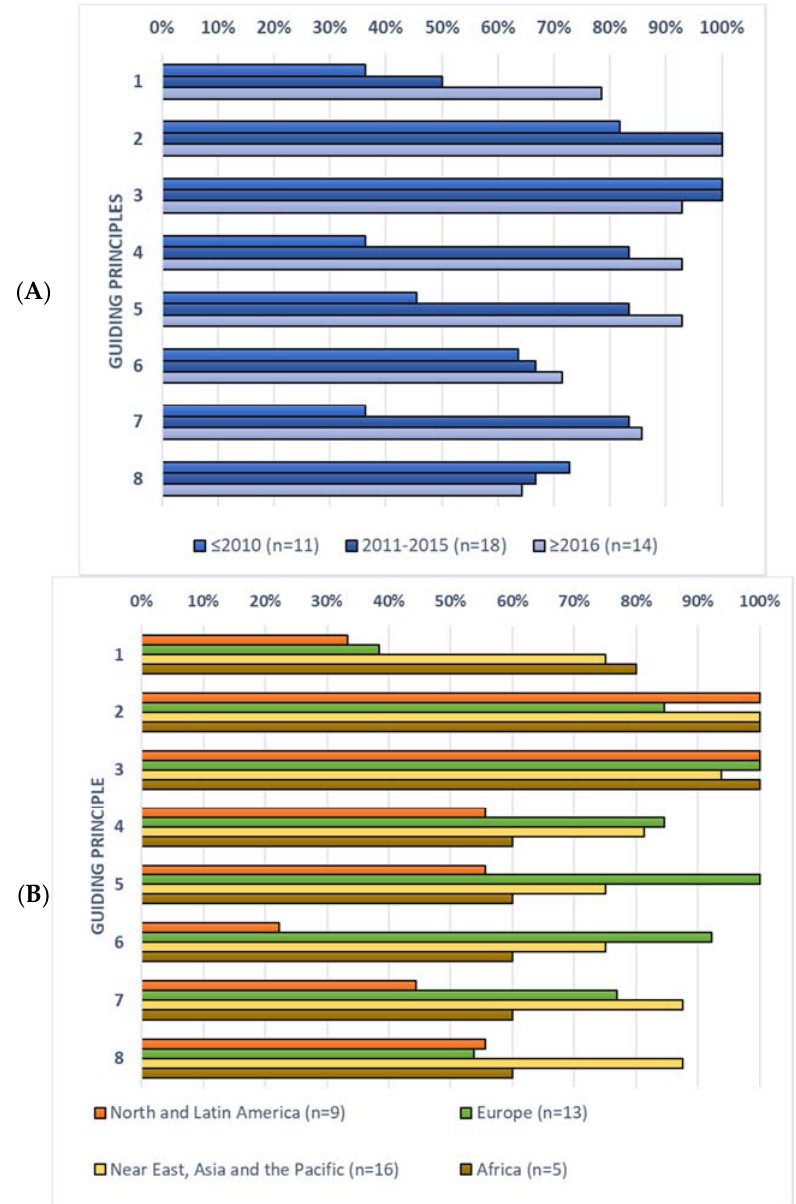
Figure 2. Rate of inclusion of the guiding principles for sustainable healthy diets related to health aspects by the 43 FBDGs included in the evaluation, divided by period of publication ( A ) and geographical macro-area ( B ).